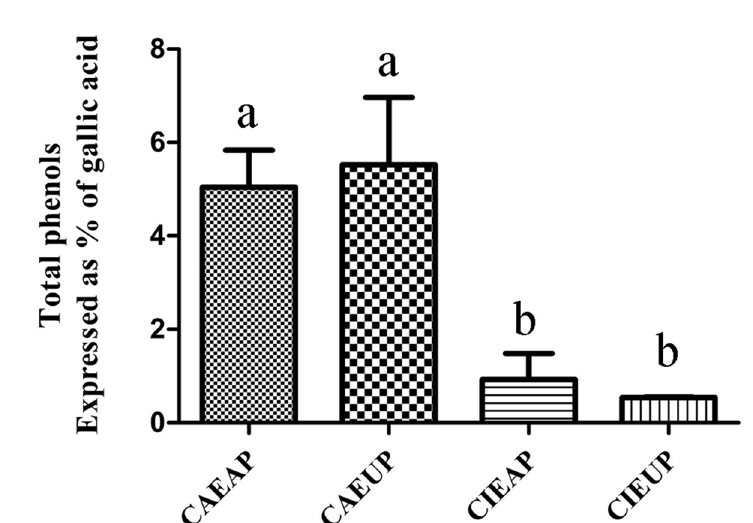
FIGURE 1 - Total phenol content of the hydroalcoholic extracts of Cyperus articulatus L . and Cyperus iria L. CAEAP: C. articulatus extract - Aerial Part; CAEUP: C. articulatus extract – Underground part; CIEAP: C. iria extract - Aerial part; CIEUP: C. iria extract – Underground